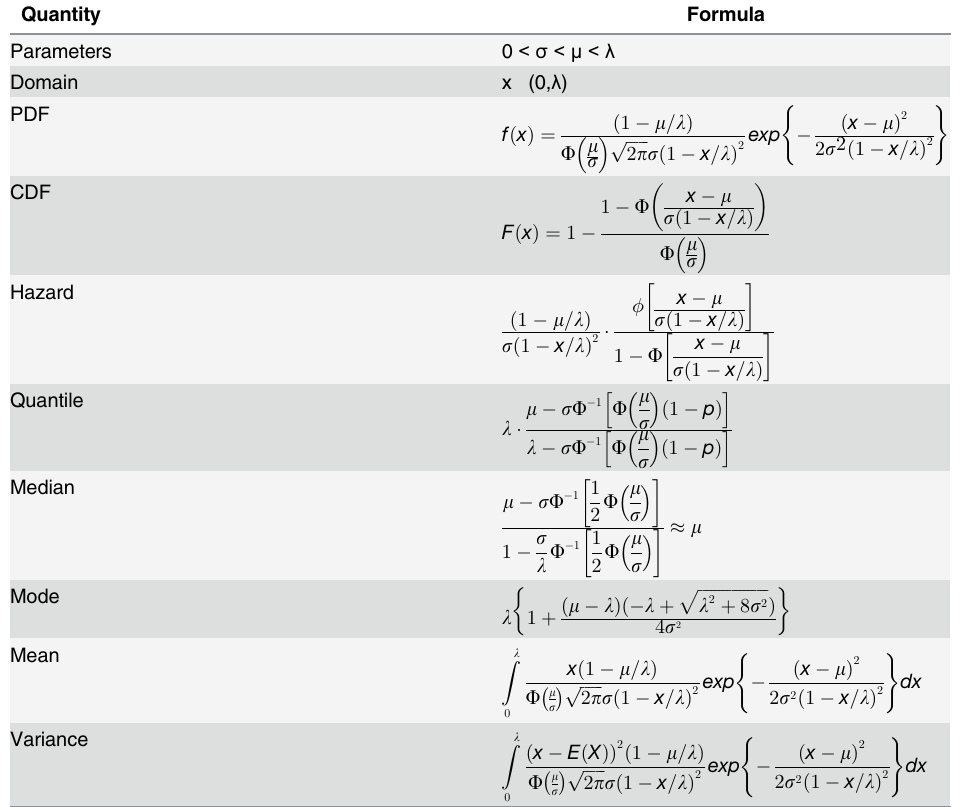
In Table 1, the “ Formula ” column for “ CDF ” is incorrect. Please see the corrected Table 1 here. Table 1. Properties of the